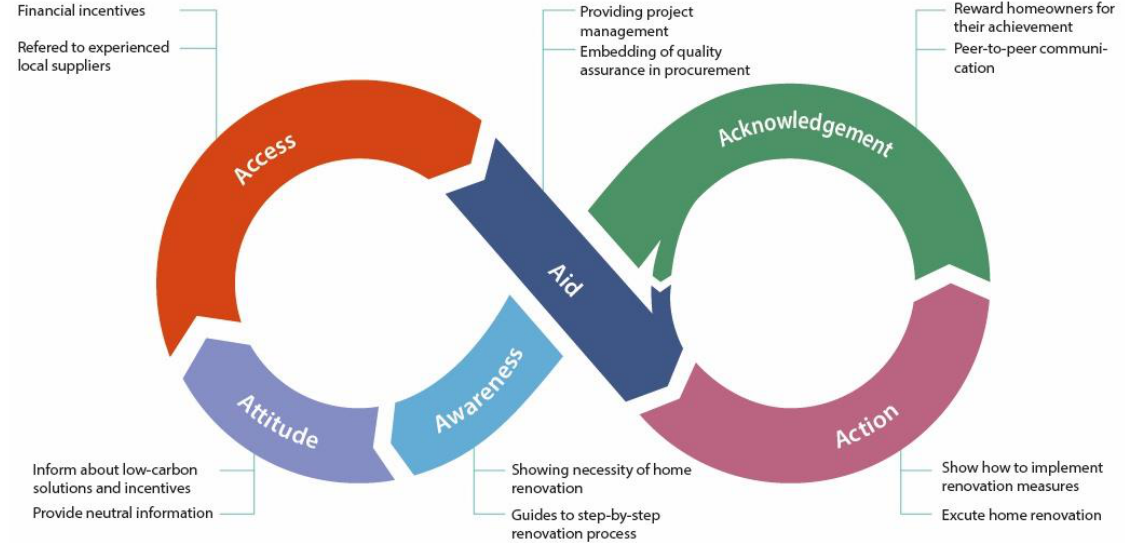
Figure 1. Homeowner renovation journey model to develop local authority web modules.